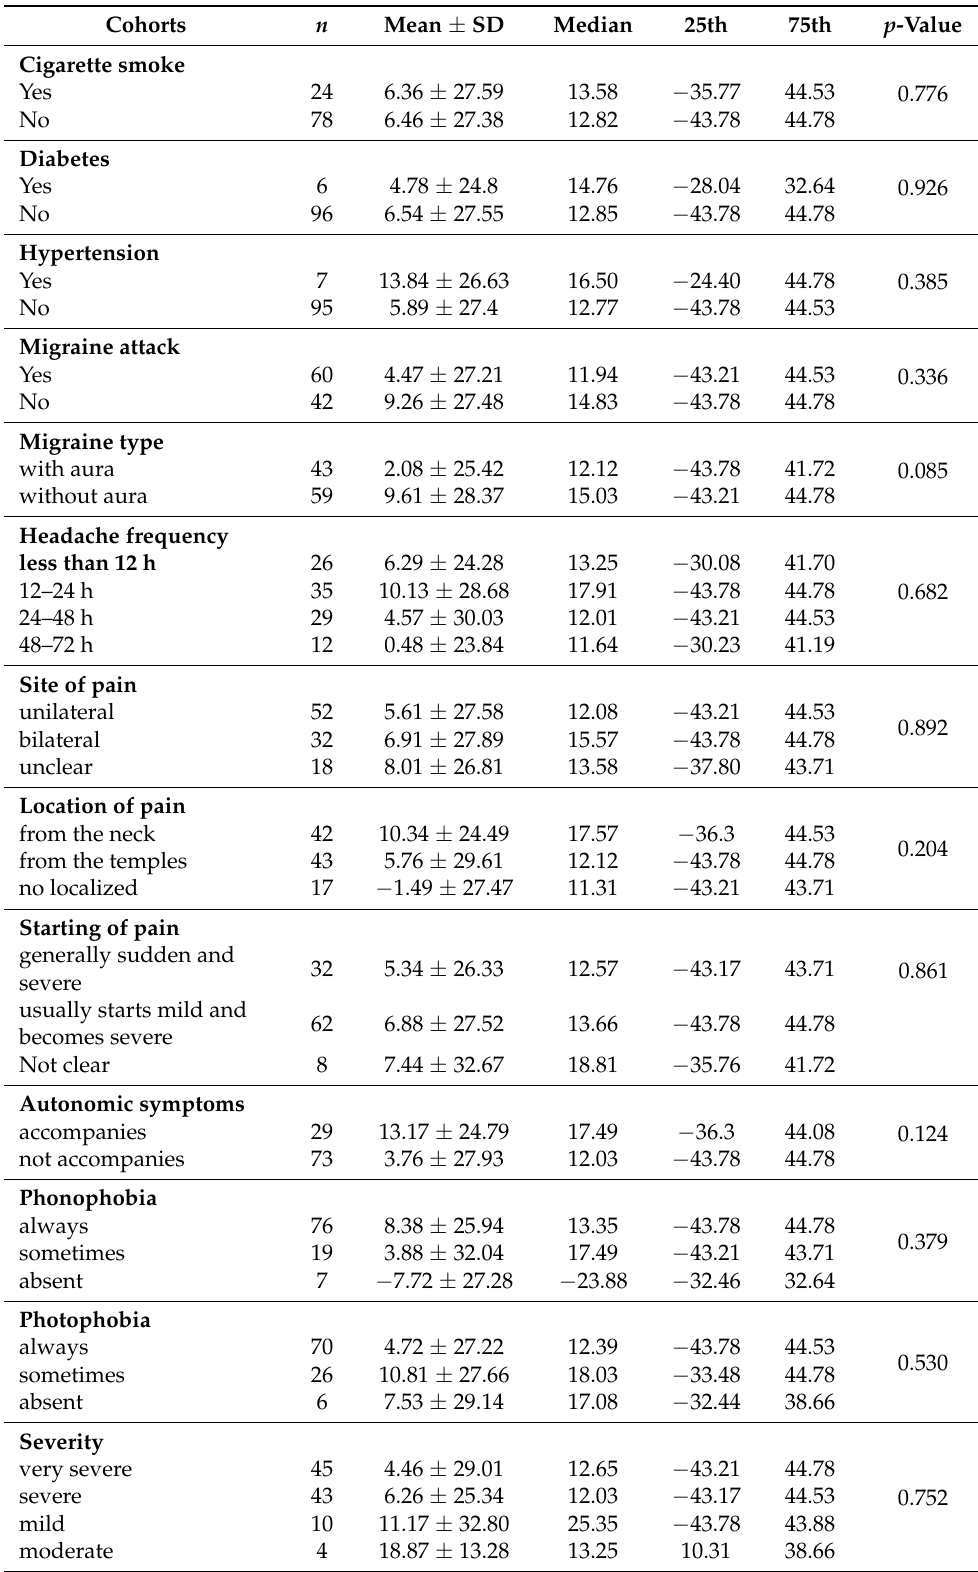
Table 6. Association of clinical characteristics and CHRNA7 gene